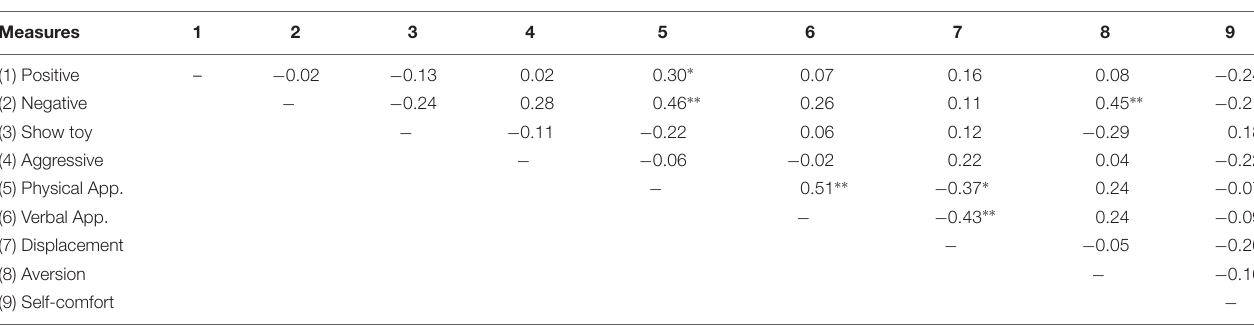
TABLE 4 | Correlations among emotion regulation variables in the SFP (phase II). Measures